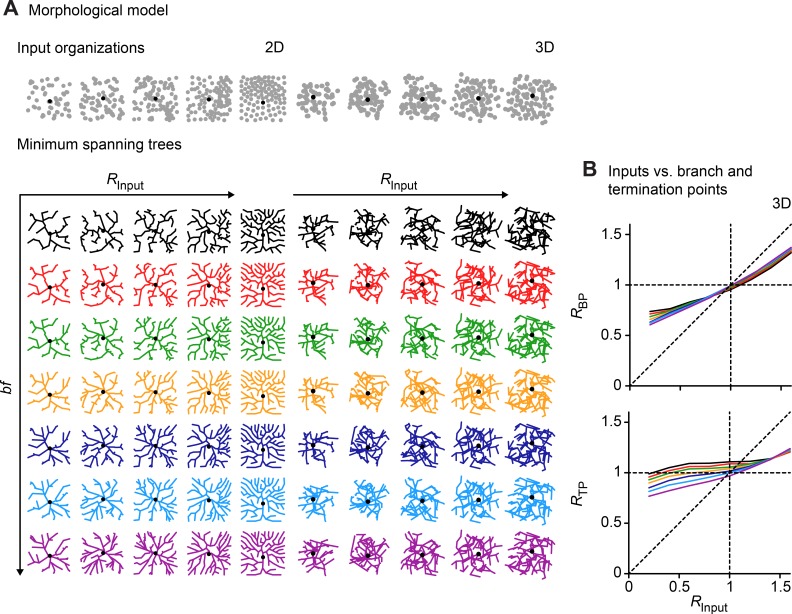
Relation between NN in the input distribution and in the dendrite’s BPs and TPs.A. Top row: 100 points (grey) distributed in a square (left, 2D) and cubic (right, 3D) area with different values of R (0.2, 0.6, 1, 1.4 and 1.8 from left to right each) using our point pattern generator. Synthetic trees to optimize wiring for different bf values are shown below each point cloud (from 0.2 to 0.8 in 0.1 increments from top to bottom), in 2D on the left for better visualization and in 3D on the right. Black dots indicate the root of the dendrite. B. Relationship between RInput and RBP as well as RTP for all 3D morphological models with N = 100 (average of 100 trees for each analyzed RInput value). We obtained similar results in the 2D case as well as for higher point densities (N > 100).